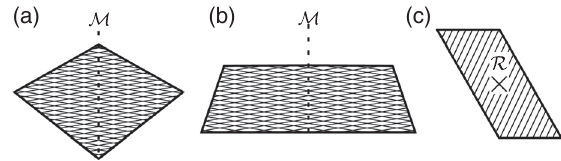
FIG. 1. Schematic pictures of a two-dimensional crystal for which the shape is compatible with mirror symmetry [(a) and (b)] and with twofold rotation symmetry (c). The crystal in (b) has a boundary that is invariant under the mirror symmetry, whereas the boundaries of the crystals in (a) and (c) appear in symmetry- related pairs. The special situation of a crystal with mirror- symmetric boundary, as shown in panel (b), is excluded from the definition of the higher-order topological